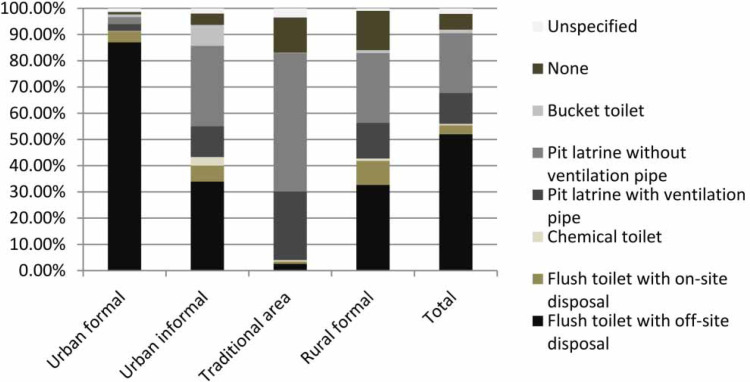
Sanitation facility access by settlement type (after Stats SA 2011).